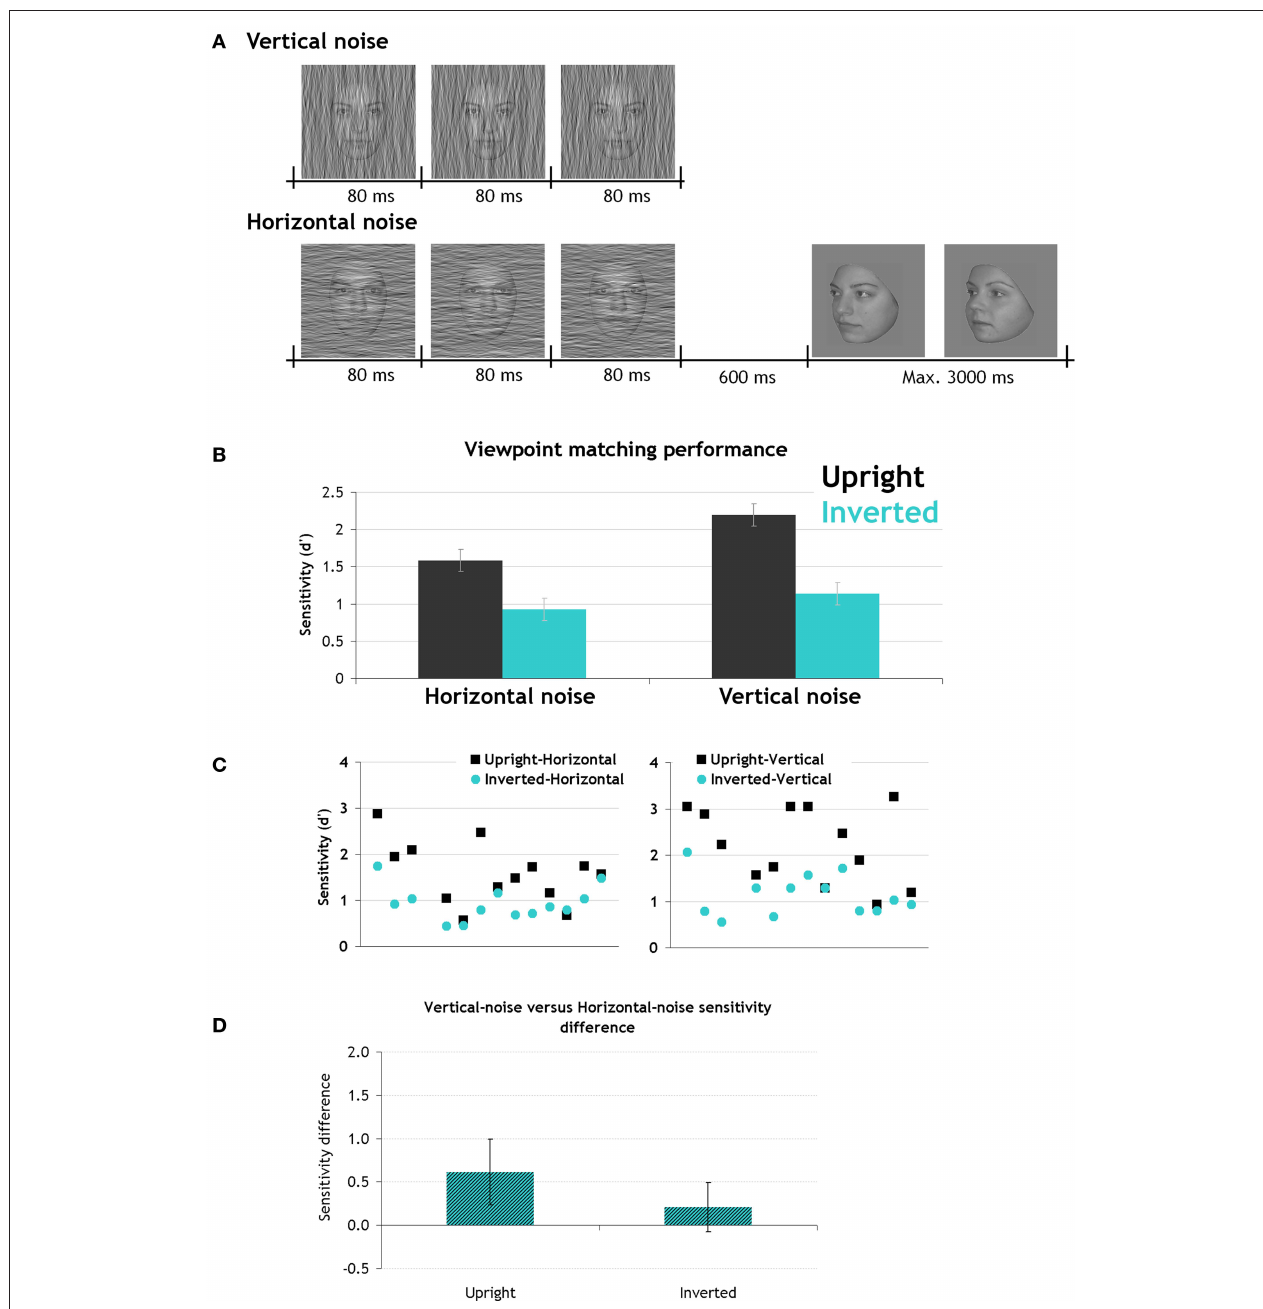
Figure 6 | (A) Stimuli and trial structure of the viewpoint matching experiment. (B) Experiment 3 results. Average discrimination sensitivity (d ′ ) as a function of noise-orientation and planar-orientation (error bars indicate MSE). ( C) Plots of